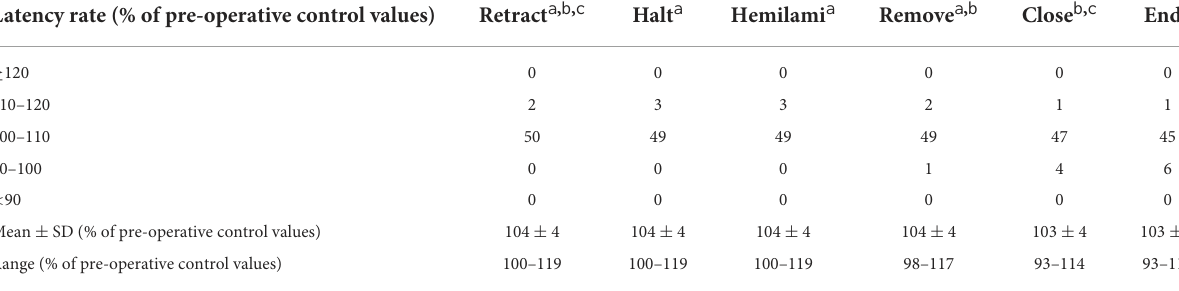
Retract, retracting multifidus muscles; Halt, halting surgical procedure and multifidus muscles loosened; Hemilami, hemilaminectomy; Remove, removing the disk materials from the spinalcanal;Close,closingmultifidusmuscles;End,endofthesurgery.Procedureswithdifferentlettersindicatesignificantdifference(p < 0.05). TABLE 2 Number of dogs in each range of latency rate of six surgical procedures. Latency rate (% of pre-operative control values) Retract a , b , c Halt